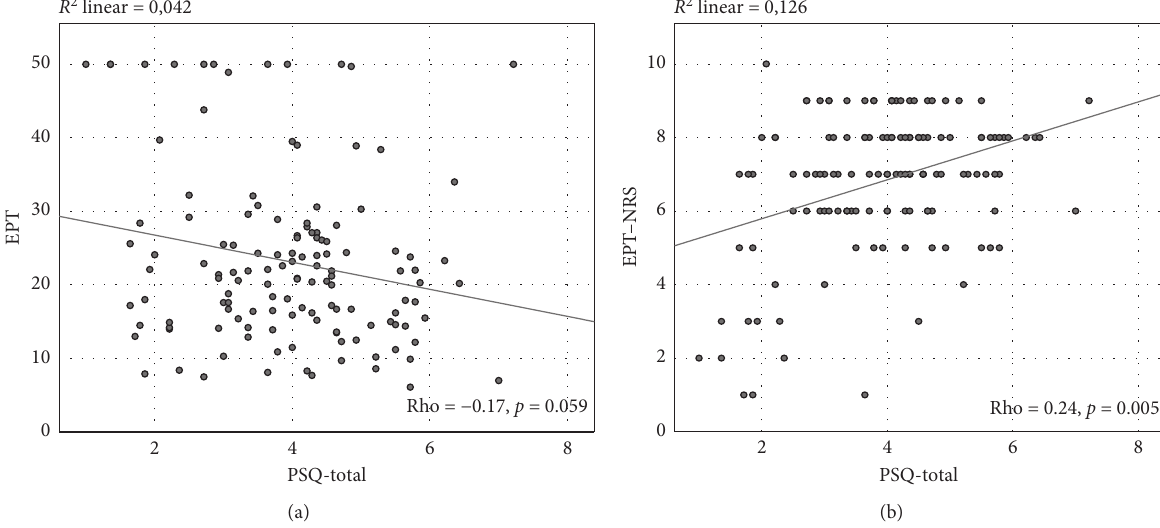
Figure 3: Illustration of the correlations between total score of the Pain Sensitivity Questionnaire (PSQ) and results of experimental electrical pain testing. (a) Correlation between the total score of PSQ (PSQ-total) and the electrical pain tolerance (EPT). (b) Correlation between the total score of PSQ (PSQ-total) and the electrical pain tolerance numerical rating scale (EPT-NRS). Linear regression lines are displayed, and Spearman’s correlation coefficients (rho) as well as p values are given ( n � 132).